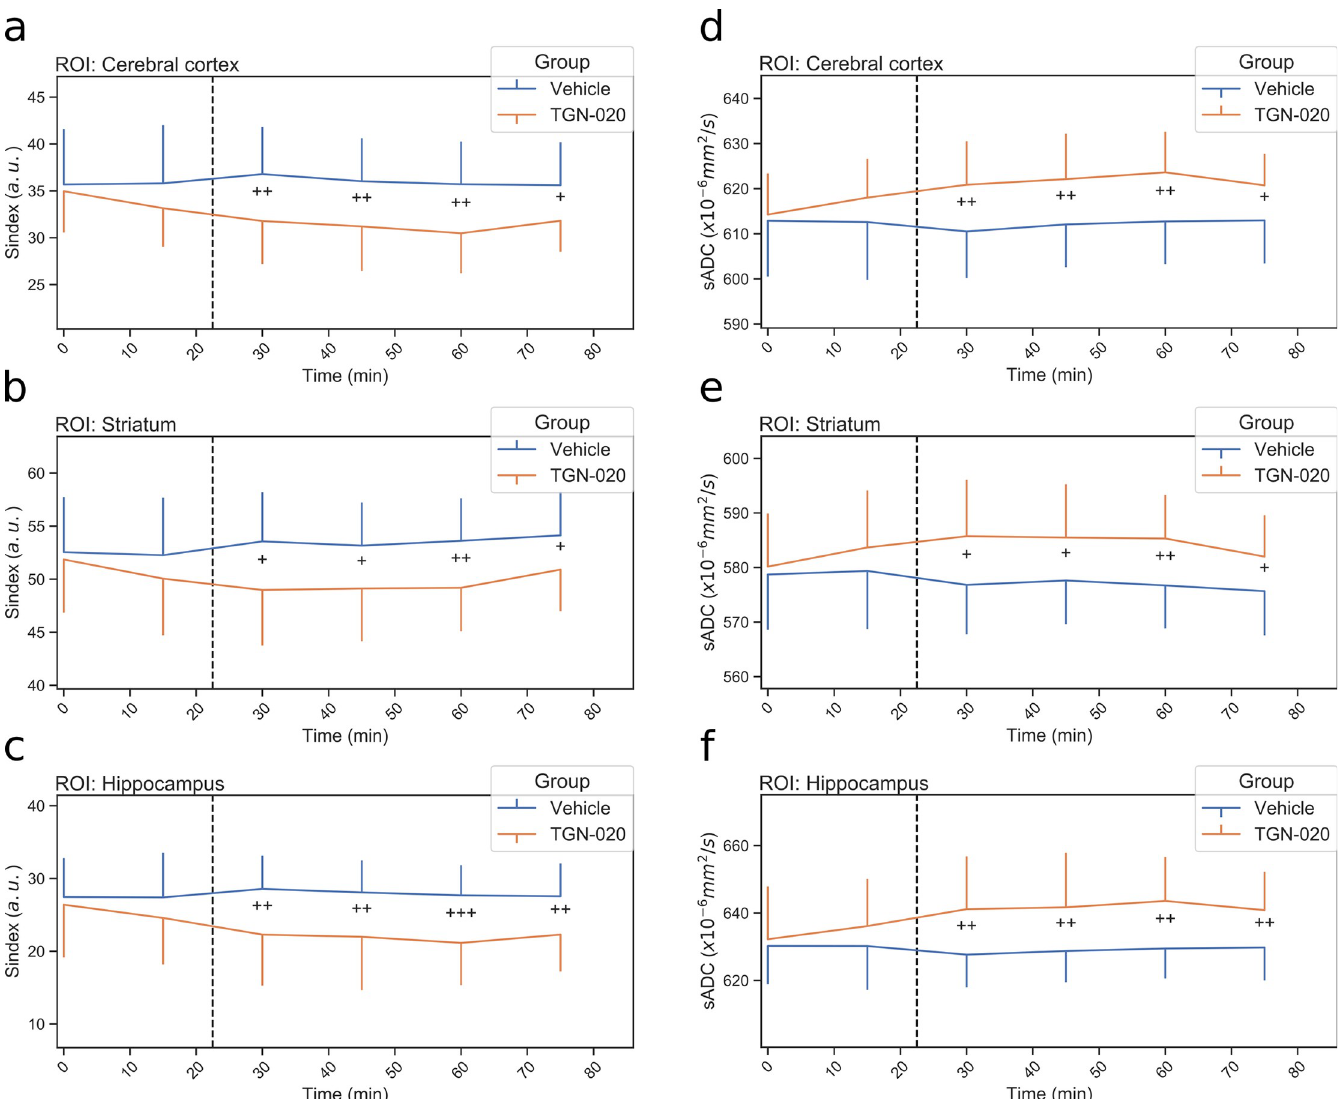
Fig 5. Time course of Sindex and sADC in the cortex (a: Sindex, d: sADC), the striatum (b: Sindex, e: sADC) and hippocampus (c: Sindex, f: sADC). Blue line is vehicle group and orange line is TGN-020 group. Error bar shows standard deviation. The dashed line represents the injection time. +: p < 0.05, ++: p < 0.01, +++: p < 0.001 by two sample t-test between the two groups for each time